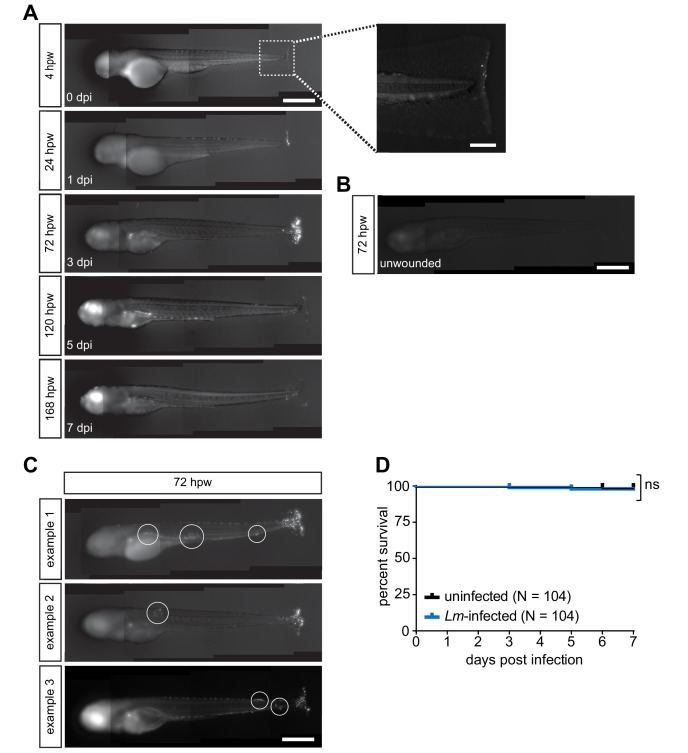
L. monocytogenes infection during tail wound infection is associated with minimal dissemination and negligible effect on host survival.(A) Wild-type larvae were wounded (B) or unwounded in presence of mCherry-expressing L. monocytogenes and fixed at indicated time points. 200-micron size z series at 5-micron steps was acquired using Zeiss zoomscope by tile imaging of the whole embryo. Maximal intensity projections of mCherry channel are displayed. Scale bar is 500 micron in whole embryo images, and 100 micron in the zoomed inset. Representative images are shown from three biological replicates; at least 10 embryos were imaged per time point per replicate. (C) an example where L. monocytogenes has disseminated is shown from each biological repeat. (D) Wild-type larvae were wounded in presence of unlabeled L. monocytogenes and survival was monitored. Data represents three biological replicates, where N indicates the total number of embryos pooled from the replicates. Statistical analysis was performed using R version 3.4 (www.r-project.org) as previously described (Vincent et al., 2016).